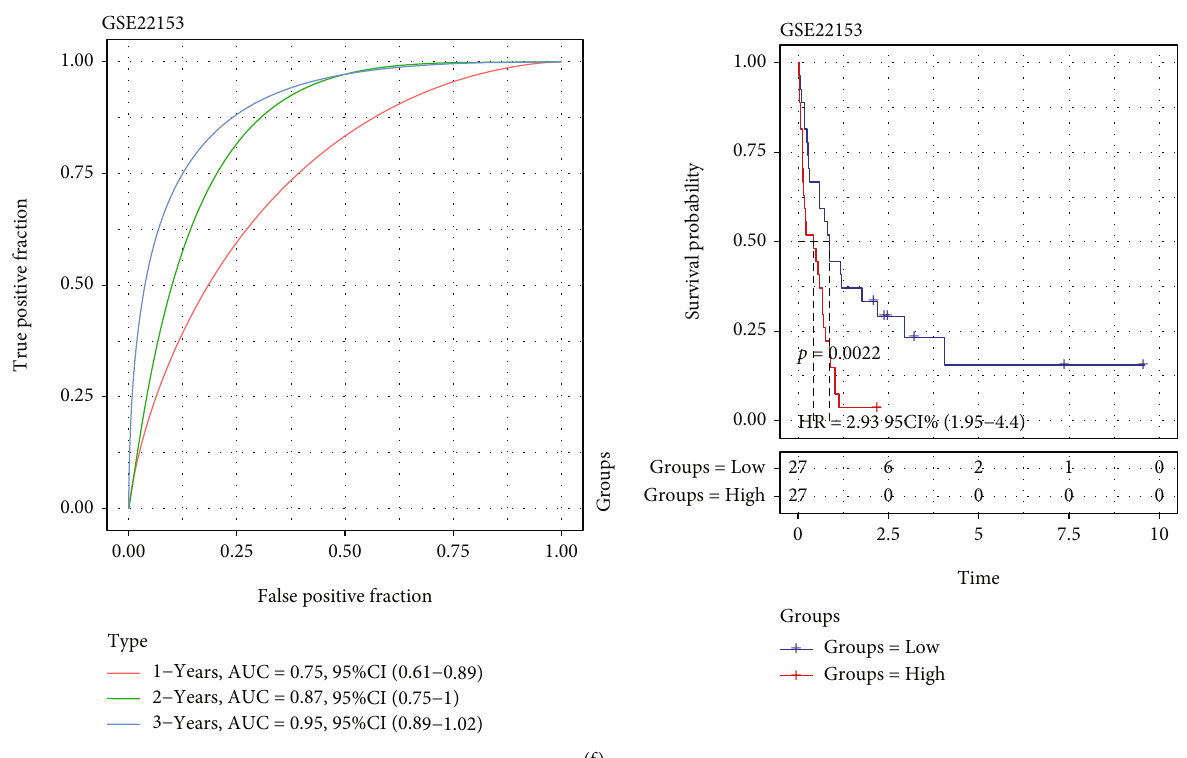
Figure 5: Association of patients ’ survival with PPRS from both training and test cohorts. (a) 8 PAG expression levels, PPRS score, status, and survival time in each case from TCGA-SKCM dataset. (b) Performance of PPRS in predicting prognosis analyzed by 1-, 3-, and 5-year ROC curves in TCGA-SKCM dataset. (c) KM analysis between high and low PPRS score patients from TCGA-SKCM dataset. (d) Performance of PPRS in predicting prognosis in GSE65904 dataset. (e) Performance of PPRS in predicting prognosis in GSE54467 dataset. (f) Performance of PPRS in predicting prognosis in GSE22153